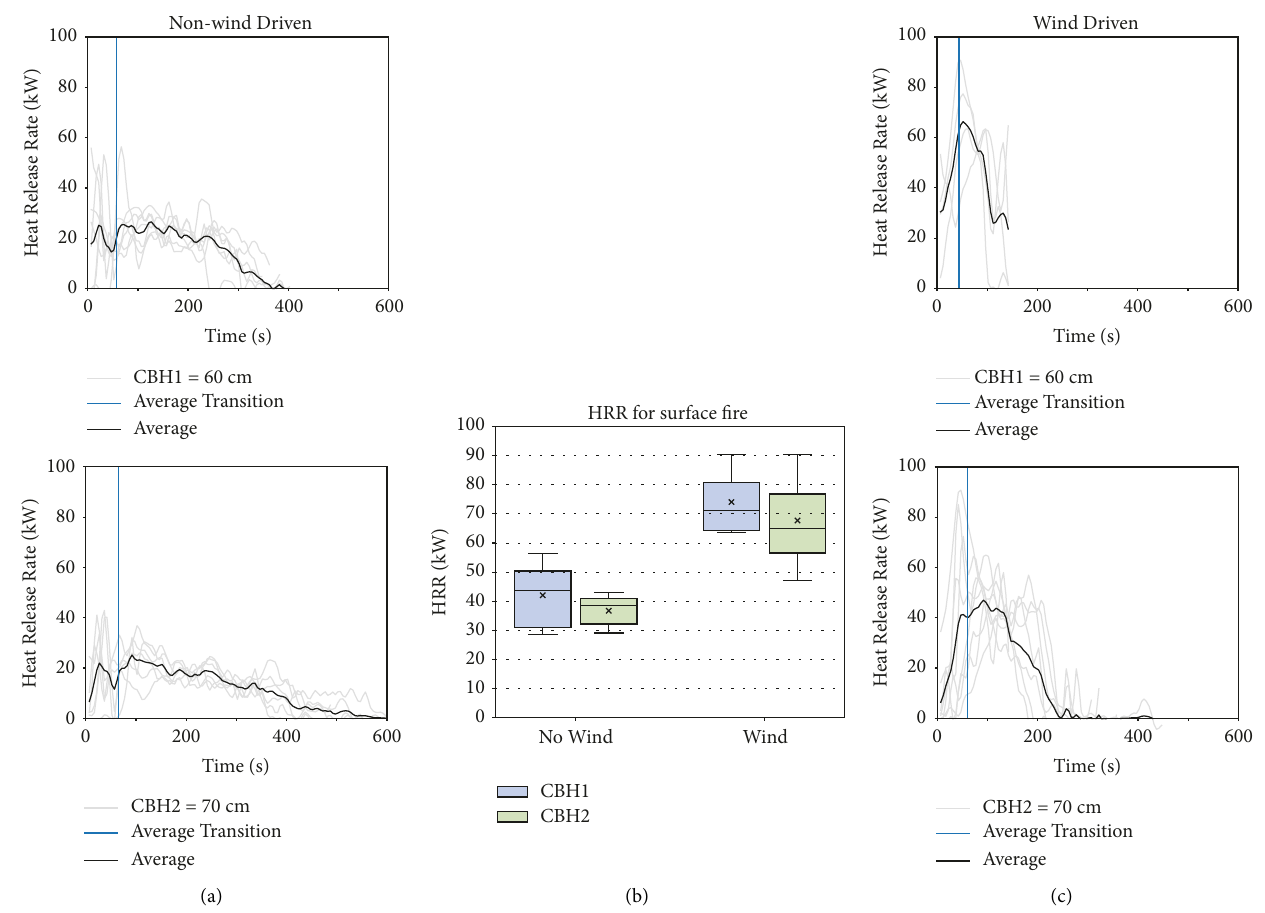
Figure 5: Surface fire heat release rate in nonwind-driven fires (a), wind-driven fires (c), and the box and whisker plot with average heat release rate for all experiments (b). For the box plot, the cross represents the mean, the horizontal bar represents the median, the bottom of the box represents the 25th percentile, the top of the box represents the 75th percentile, the bottom of the whisker is the minimum data point, and the top of the whisker is the maximum data